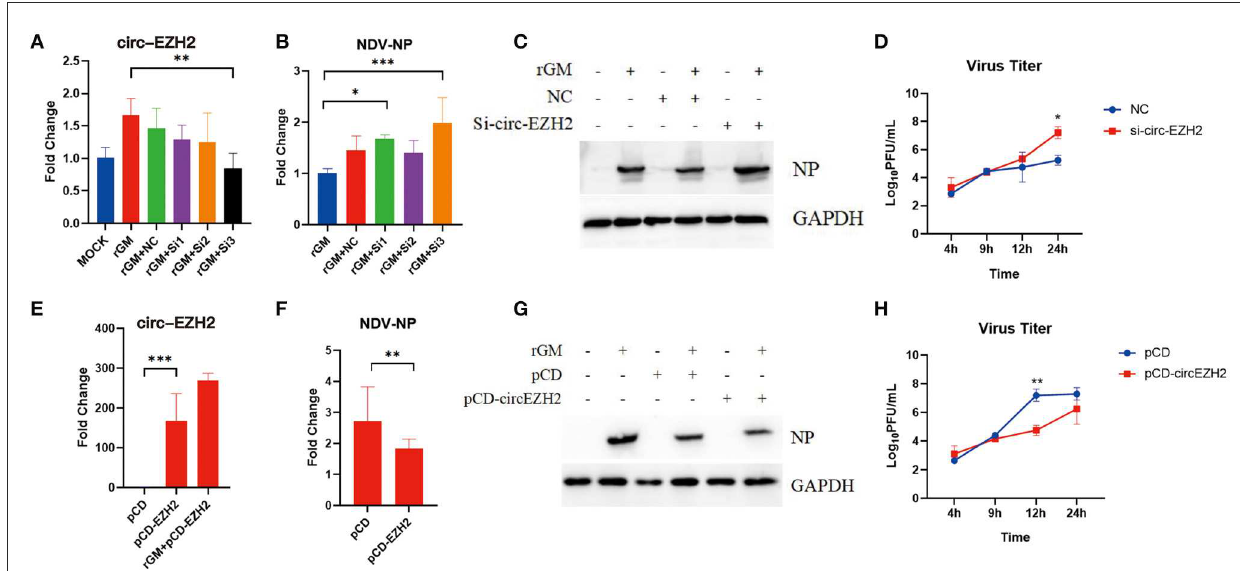
FIGURE6 NDV viral proliferation after circ-EZH2 knockdown or overexpression. (A) qRT-PCR analysis to verify siRNA efficiency of the circ-EZH2 knockdown. (B) qRT-PCR analysis to measure NP gene production post-NDV infection during circ-EZH2 knockdown. (C) Western blot analysis to measure NP gene production post-NDV infection during circ-EZH2 knockdown. (D) NDV replication post NDV infection during circ-EZH2 knockdown. (E) qRT-PCR analysis to verify circ-EZH2 overexpression. (F) qRT-PCR analysis to measure NP gene production post-NDV infection during circ-EZH2 overexpression. (G) Western blot analysis to measure NP gene production post-NDV infection during circ-EZH2 overexpression. (H) NDV replication post NDV infection during circ-EZH2 expression.